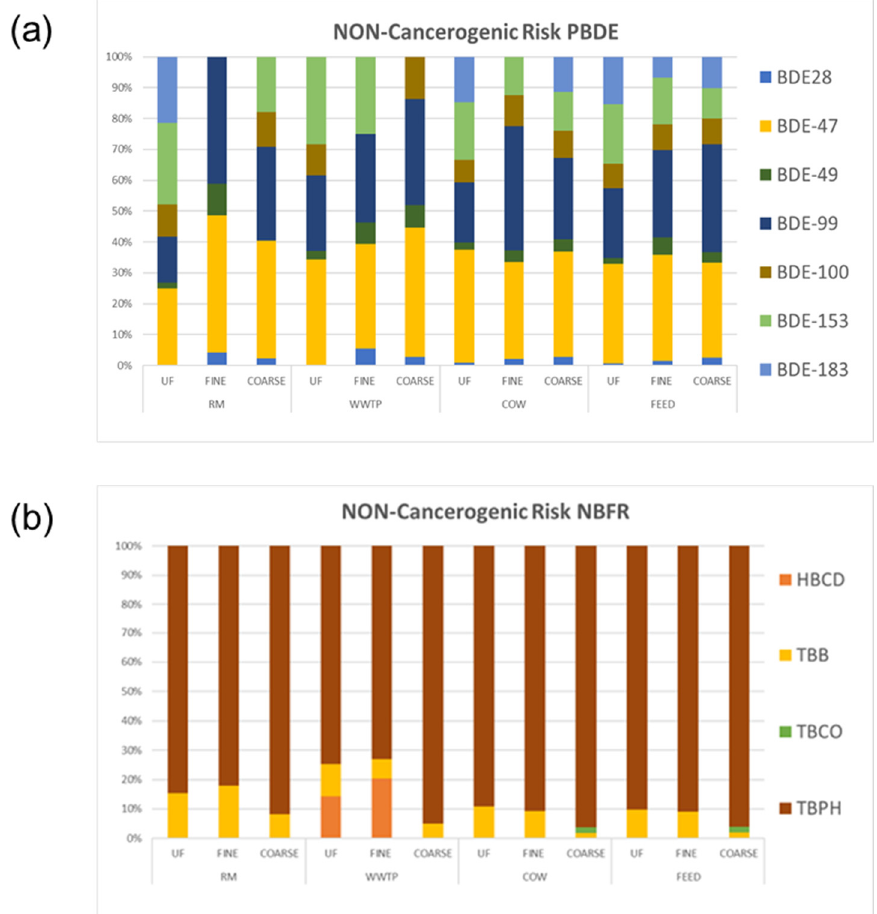
Figure 16. Non-carcinogenic risk percentage associated with each single compound in ultrafine, fine and coarse fractions of PM for all the sites. ( a ). Non-Cancerogenic Risk PBDE. ( b ) Non-Cancerogenic Risk NBFR.